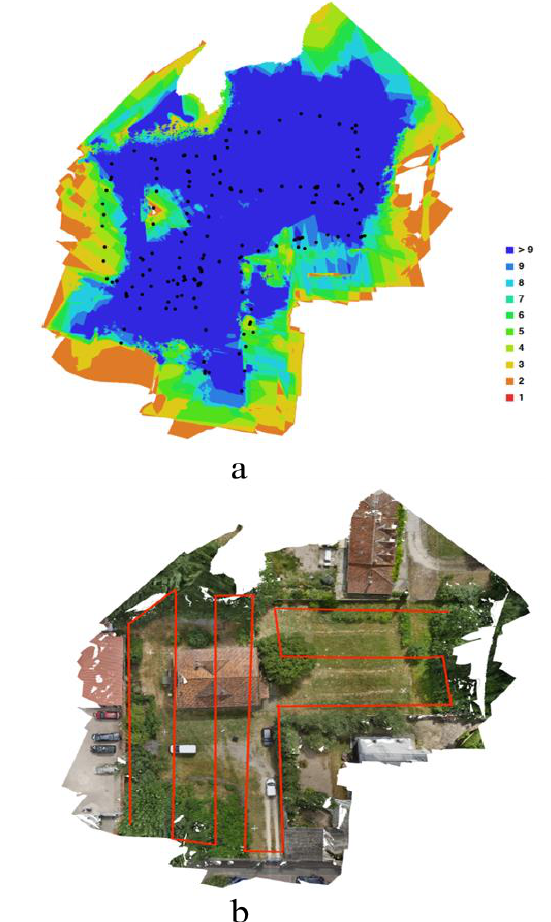
Figure 4: (a) image overlapping level; (b)